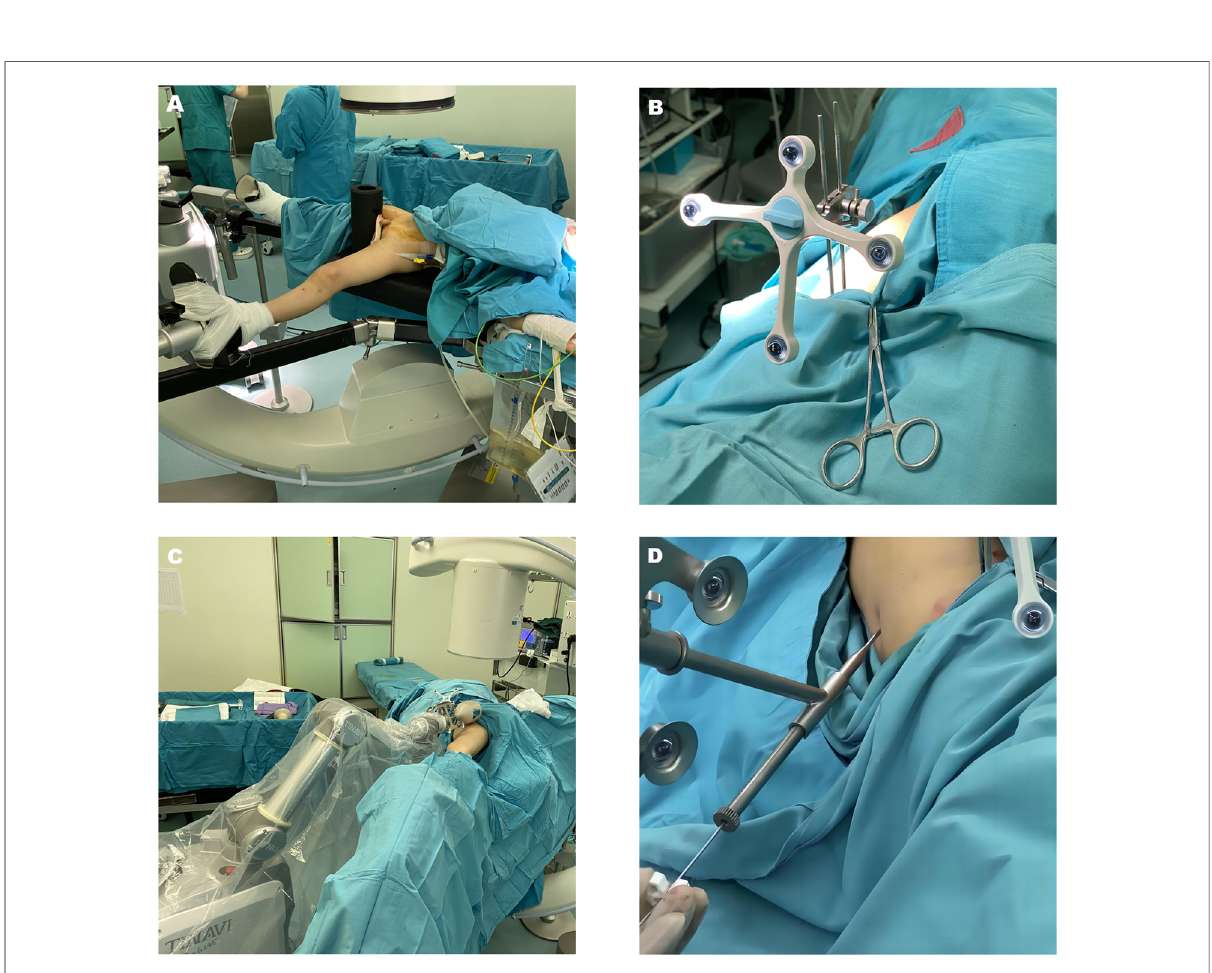
FIGURE 1 The key surgical steps of the robot-assisted surgery. ( A ) The patient was placed on a traction bed; ( B ) The patient tracking device was fi xed on the anterior superior iliac spine of the affected side. ( C ) Obtain the intraoperative fl uoroscopy image containing the robot positioning marking point; ( D ) Placed a guide pin near the skin through a sleeve on mechanical